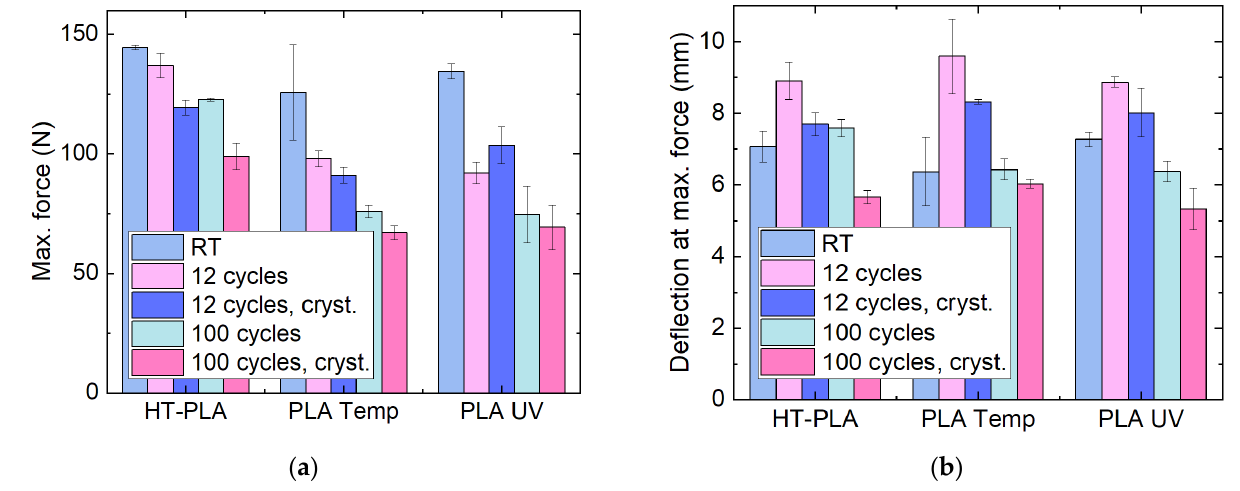
Figure 16. Mechanical properties of chosen PLA materials after cyclic thermal tests in the climate chamber: ( a ) maximum force; ( b ) deflection at maximum force in 3-point bending tests.